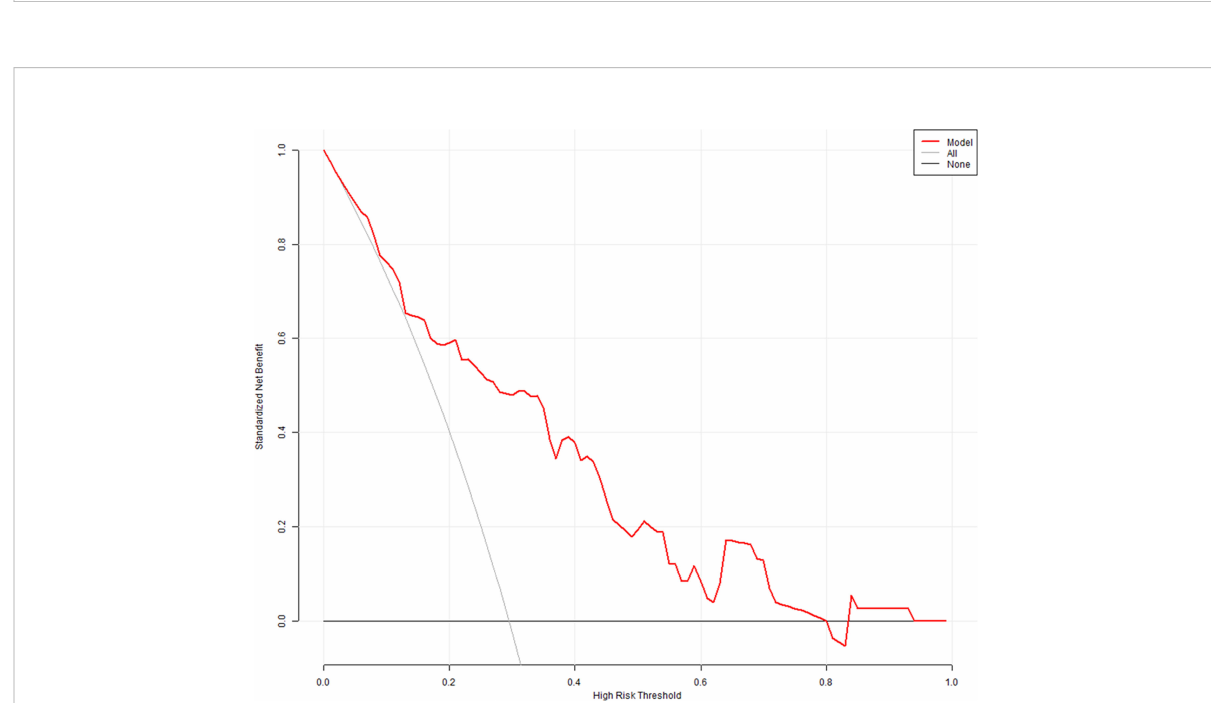
FIGURE 6 Decision curve analysis (DCA). The x - and y -axes represent the threshold probability and standardized net bene fi t, respectively. Red, gray, and black lines represent data acquired with the prediction nomogram model, the assumption that all patients had a high risk of dif fi cult surgery, and the assumption that no patients had a high risk of dif fi cult surgery,